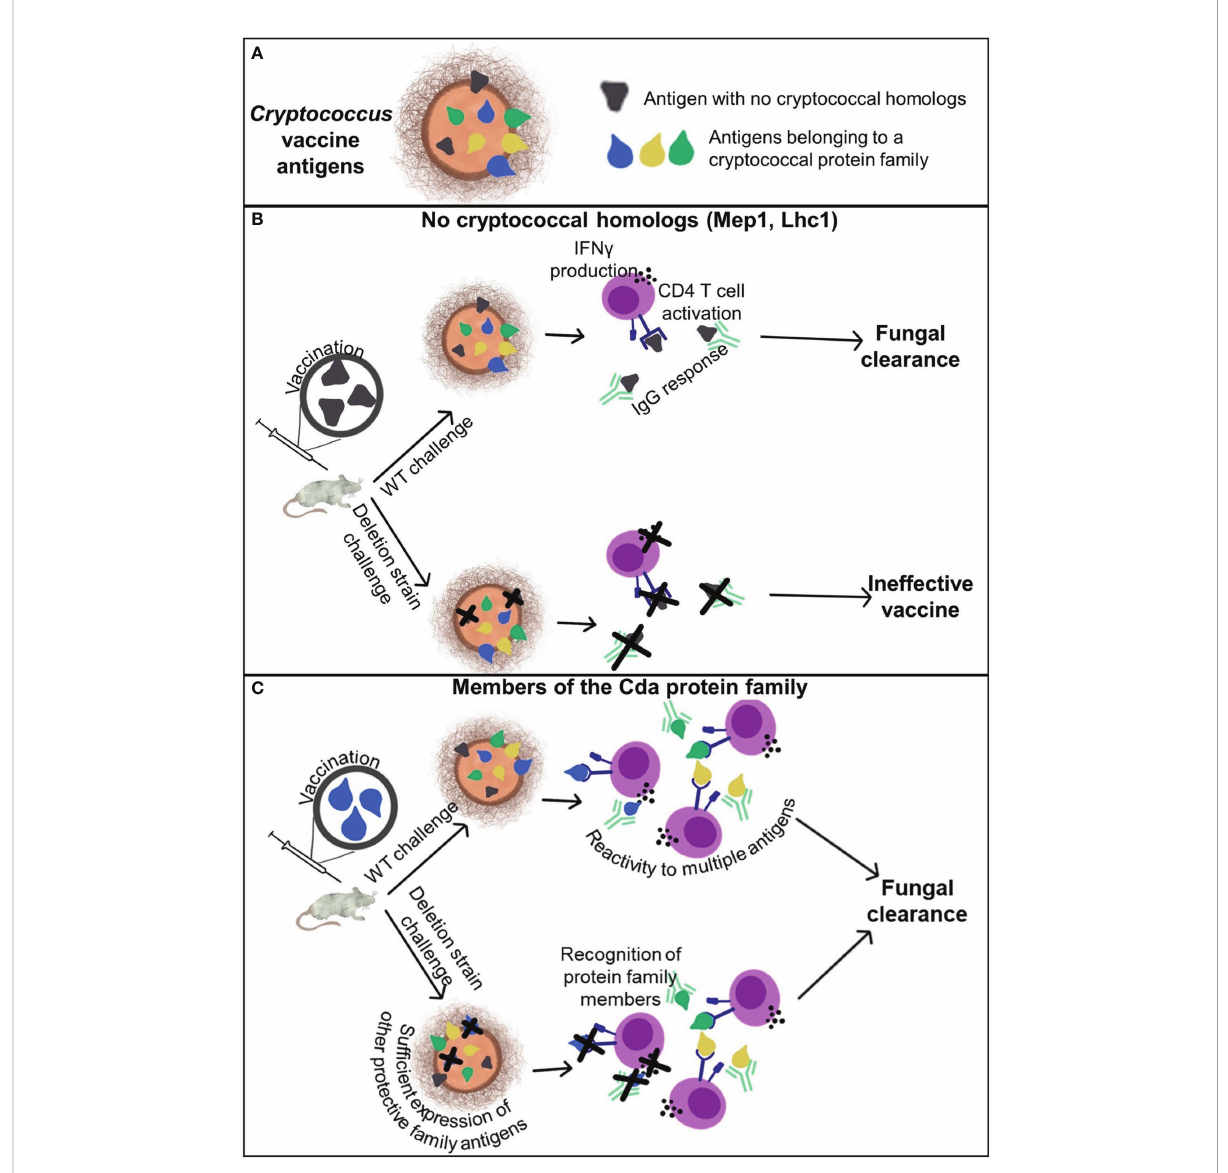
FIGURE 6 Cross-reactivity and cross-protection generated by cryptococcal vaccination. (A) Cryptococcal antigens can be categorized by those that have no homologs within the genome and those belonging to a protein family. (B) Antigens which do not have any homologs are protected by the adaptive immune response to the respective recombinant protein vaccine only when the antigen is present in the challenge strain. (C) Vaccination with a single antigen that belongs to a protein family, such as the Cda family, can elicit protective adaptive immune responses to the vaccine antigen as well as other antigens within the family. This enables vaccine-mediated protection against deletion strains of Cryptococcus lacking the vaccine